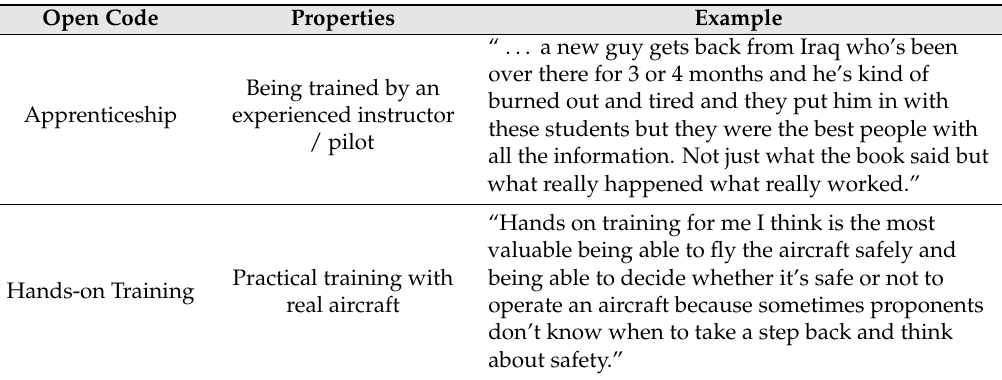
Table A3. Research Question: What aspects of training were most beneficial?